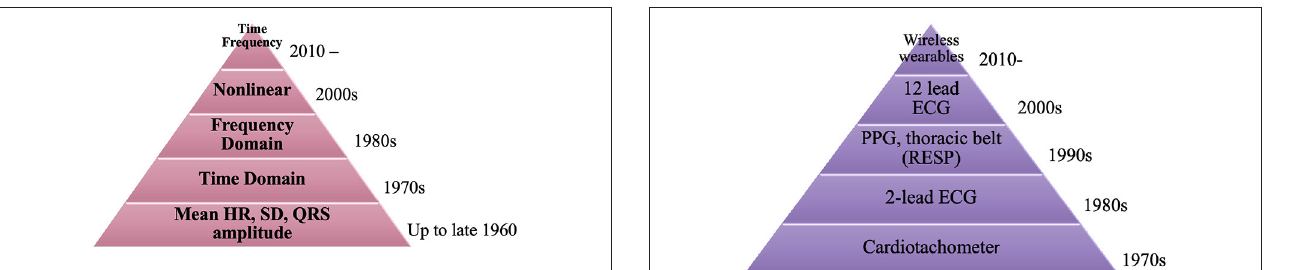
FIGURE 4 | Evolution of medical devices utilized for HRV data acquisition.